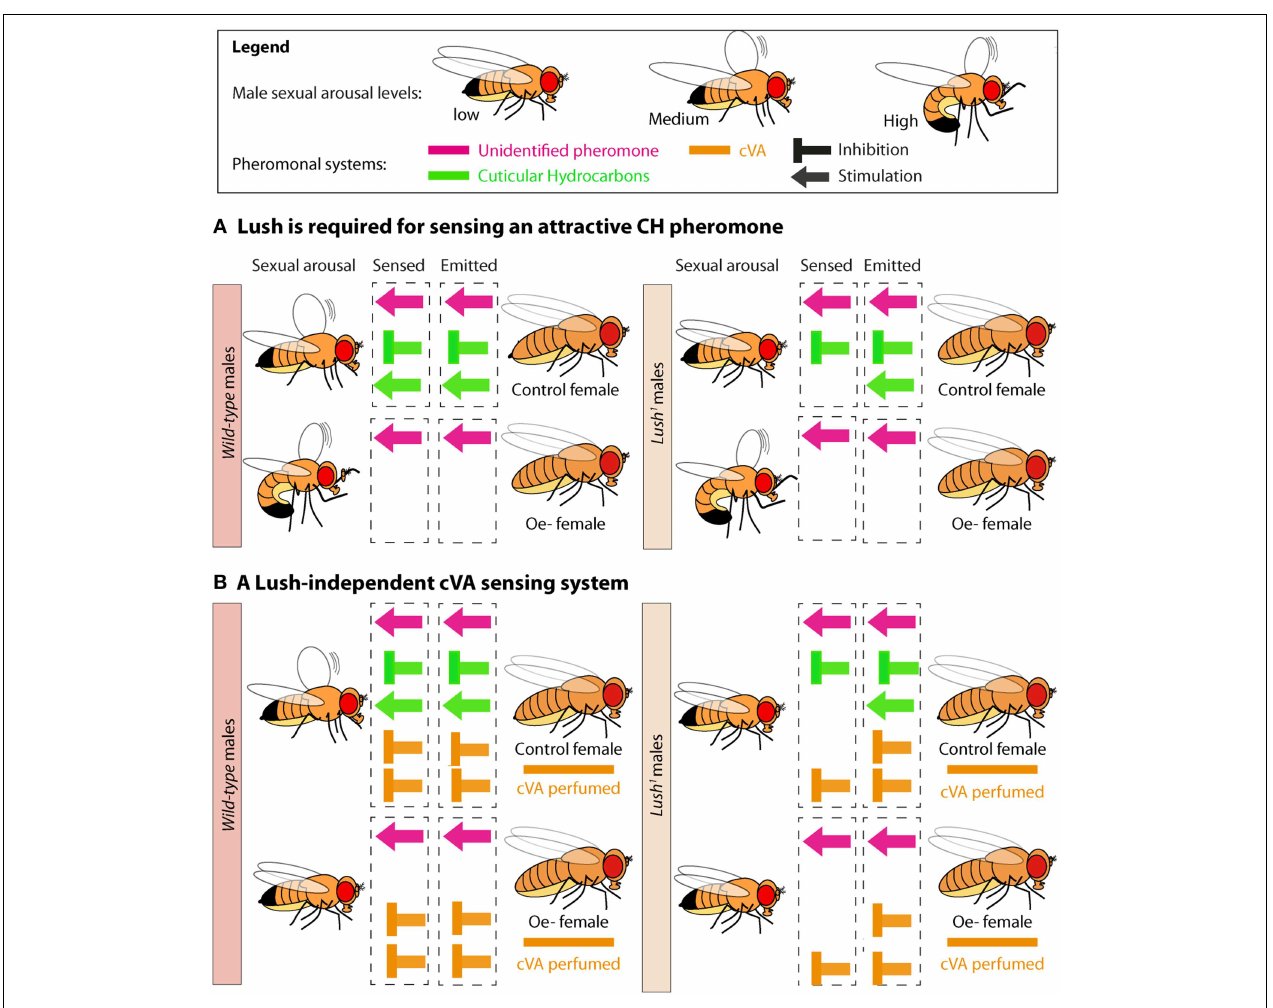
pheromone not originating from the oenocytes. (B) lush mutant males may suppress courtship toward females perfumed with cVA because they can still sense cVA via a second sensory channel. The strong inhibitory effect of cVA-perfuming on Oenocyte-less (Oe − ) females would be linked to a failure by males to sense the stimulatory pheromone coming from the CH